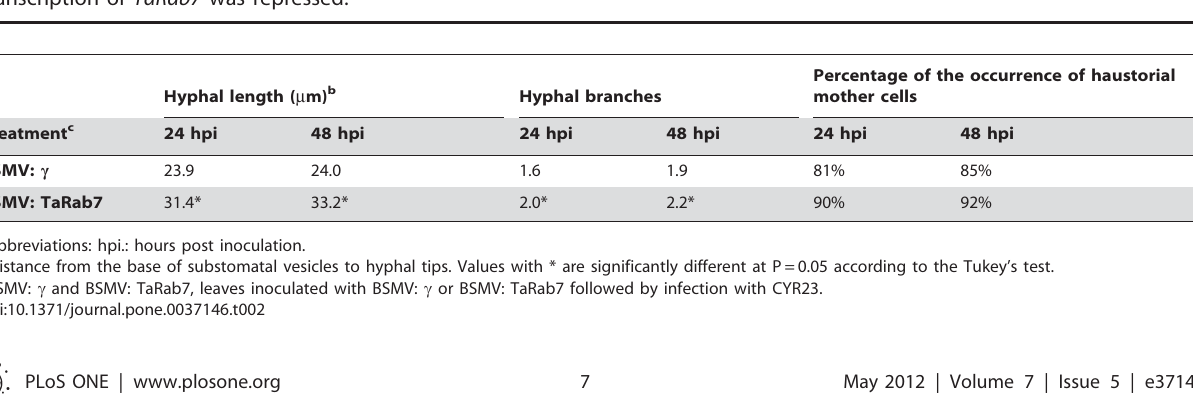
Table 2. Histological observations during the incompatible interaction between wheat and the stripe rust fungus when the transcription of TaRab7 was repressed.